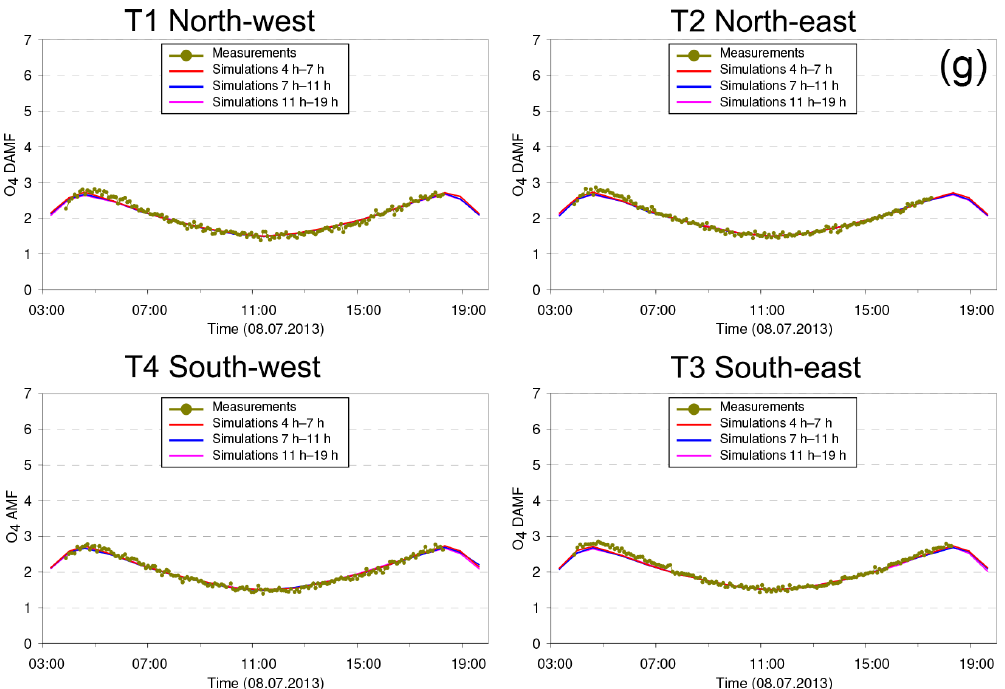
Figure A3. (a) Comparison results for 1 ◦ elevation angles on 8 July 2013. The upper lines indicate the O 4 AMFs; the lower lines indicate the O 4 dAMFs (see also Figs. 2 and 3). (b) Comparison results for 3 ◦ elevation angles on 8 July 2013. (c) Comparison results for 6 ◦ elevation angles on 8 July 2013. (d) Comparison results for 10 ◦ elevation angles on 8 July 2013. (e) Comparison results for 15 ◦ elevation angles on 8 July 2013. (f) Comparison results for 30 ◦ elevation angles on 8 July 2013. (g) Comparison results (only O 4 AMFs) for 90 ◦ elevation angles on 8 July